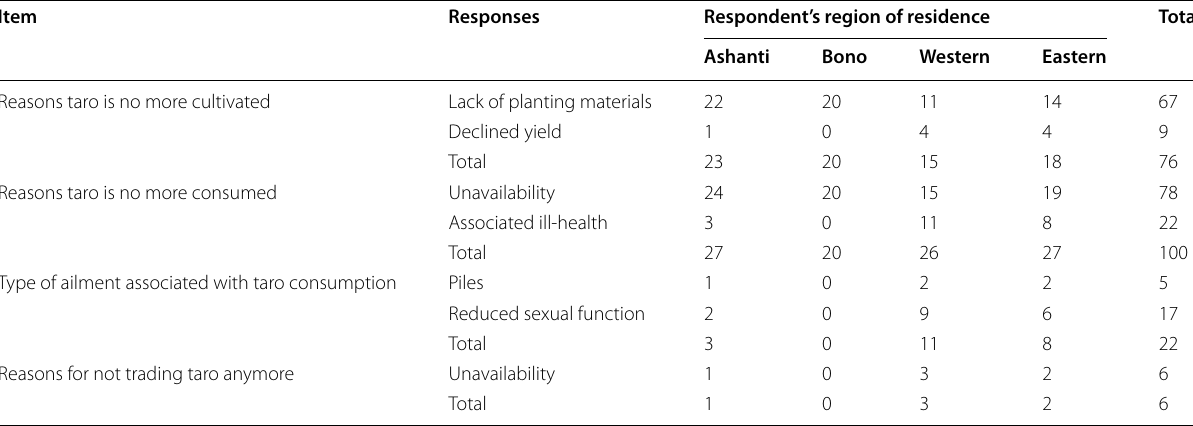
Table 5 Possible causes of taro endangerment